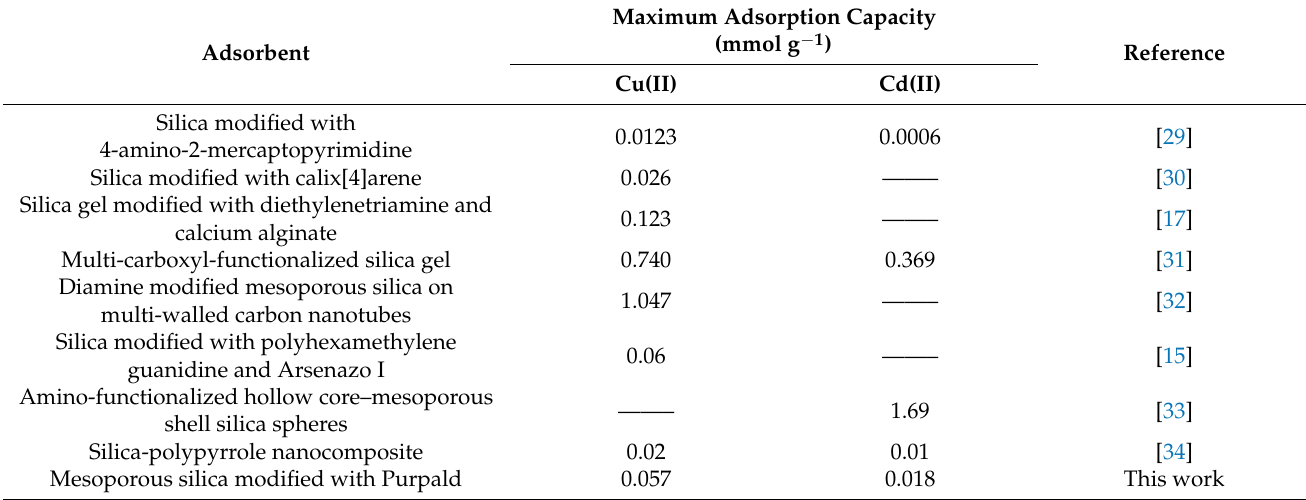
Table 4. Adsorption capacity of silica-based adsorbents for the extraction of Cu(II) and